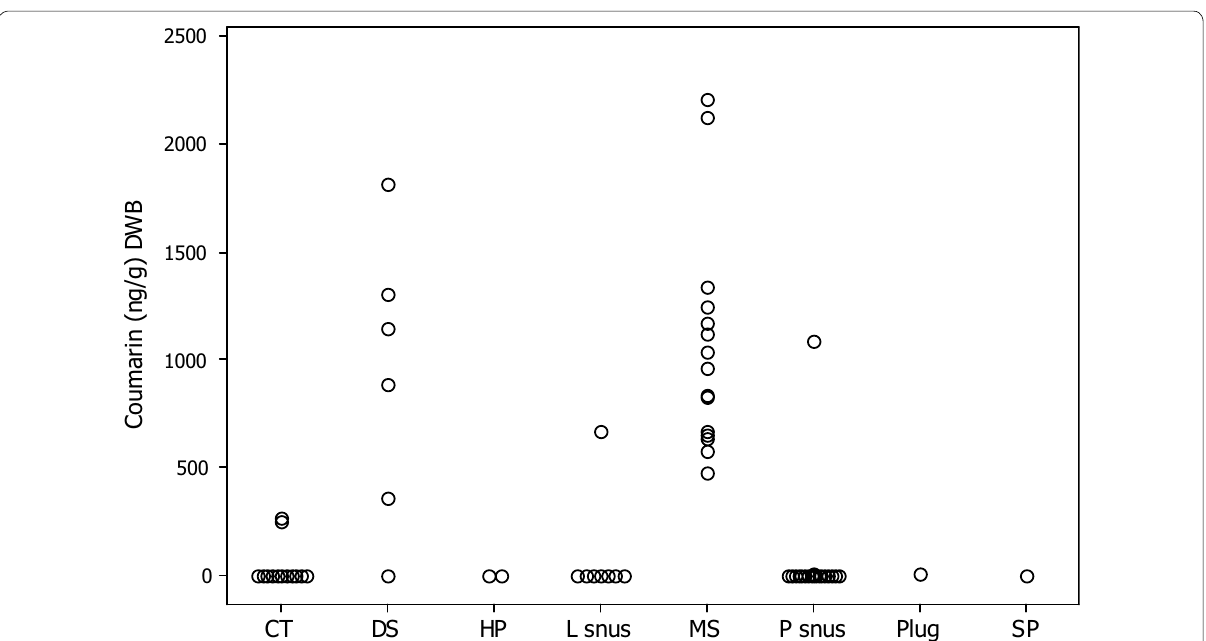
Fig. 4 Individual value plot: coumarin concentrations (ng/g STP DWB) by STP style. Concentrations < LOD or LOQ are shown as 0